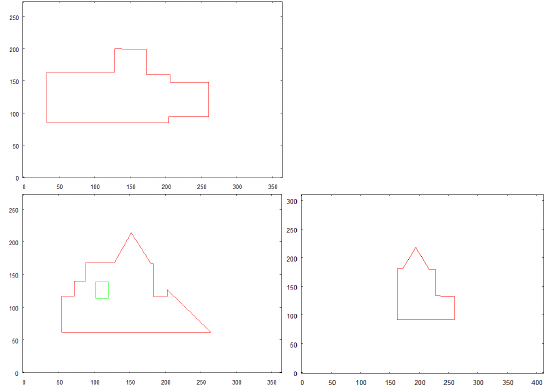
Figure 12. Result of vectorization of projections of building